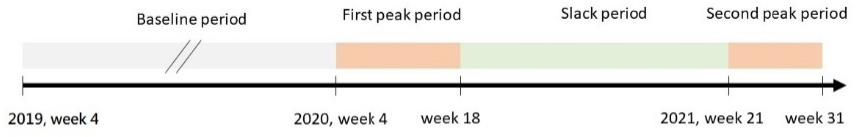
Figure 1. The definition of study periods. Period 1 week 4–18, and study period 2 week 21–31.